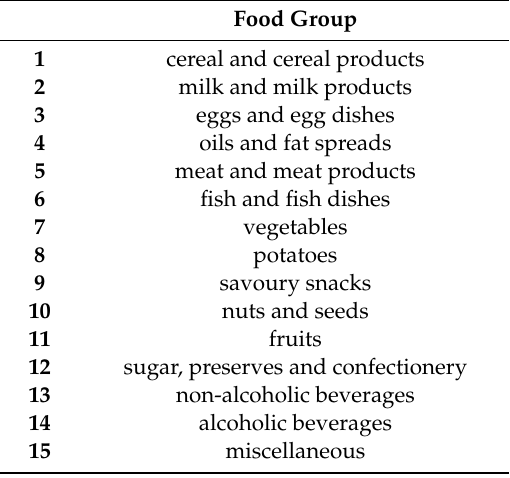
Table 1. List of fifteen first-level food groups used for dietary assessment and